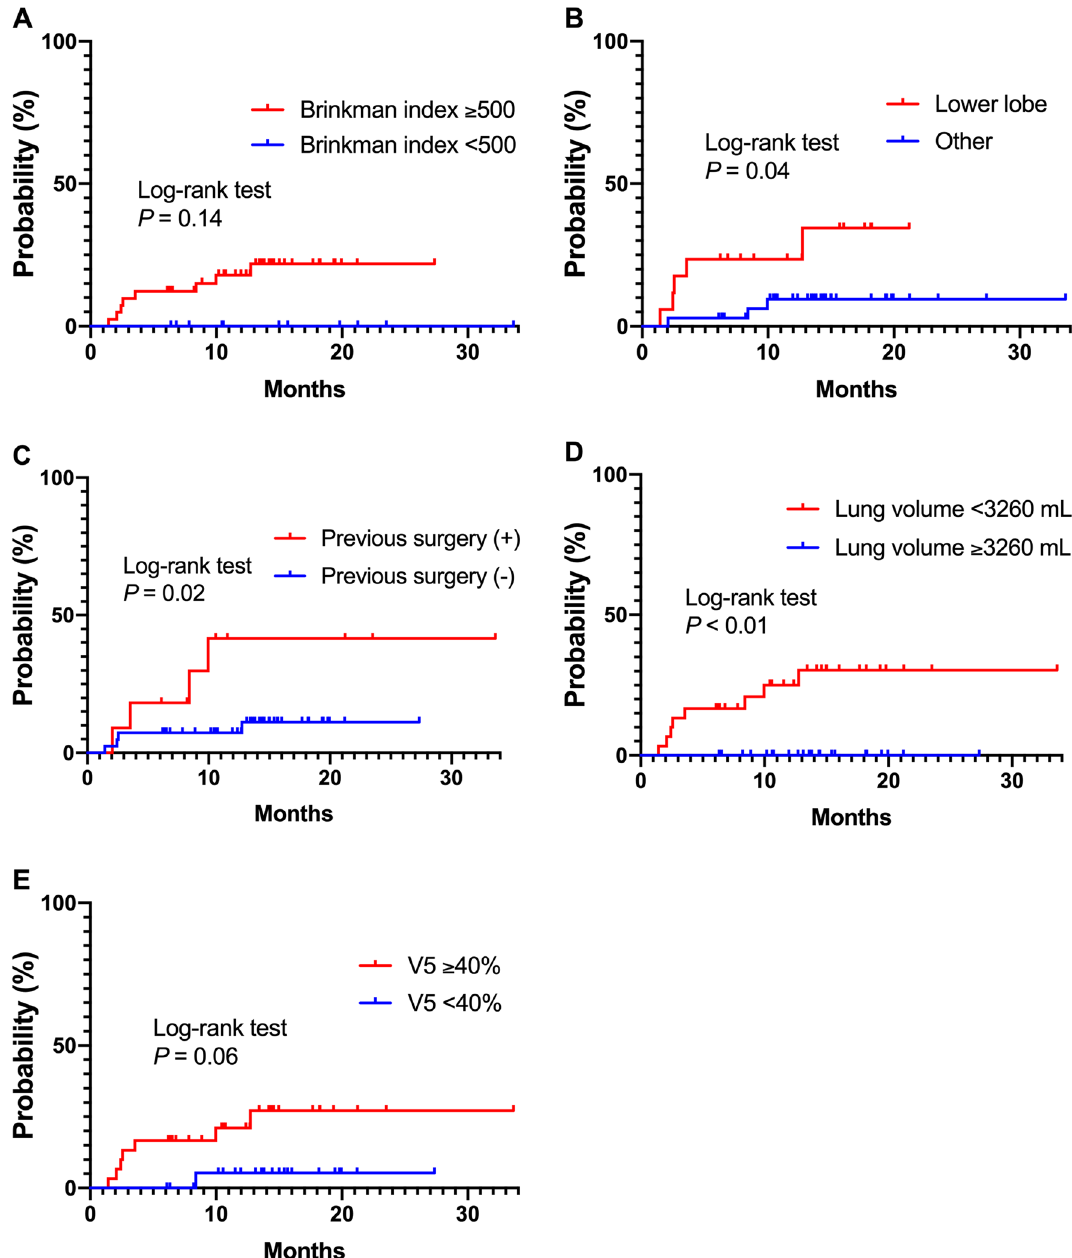
Figure 3. The cumulative incidence of grade ≥ 3 radiation pneumonitis (RP) according to each potential risk factor. The cumulative incidence of grade ≥ 3 RP is presented for each potential risk factor identified as significant in univariate analysis. V5, lung volume receiving a dose of ≥ 5